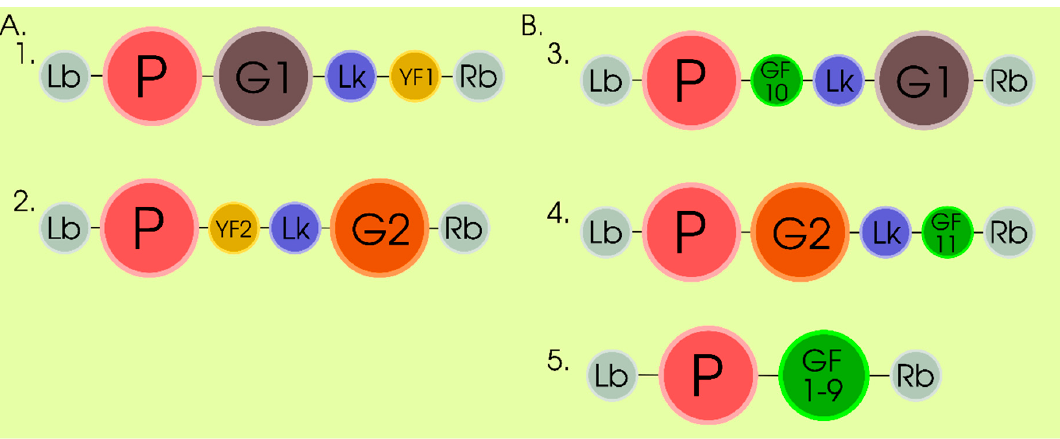
Figure 4. Scheme of T-DNA gene constructs for the study of protein–protein interactions using bimolecular fluorescence complementation (BiFC) analysis ( A ) and tripartite complementation system ( B ). A: 1 and 2—constructs for studying protein–protein interactions in plants using BiFC, where G1, G2—genes of interacting proteins, YF1, YF2— subdomains of YFP (YFP—yellow fluorescent protein). B: 3, 4 and 5 - constructs for studying protein–protein interactions in plants using tripartite system, where G1, G2—genes of interacting proteins, GF1-9, GF10, GF11—subdomains of GFP (GFP – green fluorescent protein). General notation for A and B: P— promoter (for tripartite system— β -estradiol–induced expression, as rule), Lk—flexible linker. Lb, Rb—T-DNA left and right borders. The principle of using systems is described in the text.